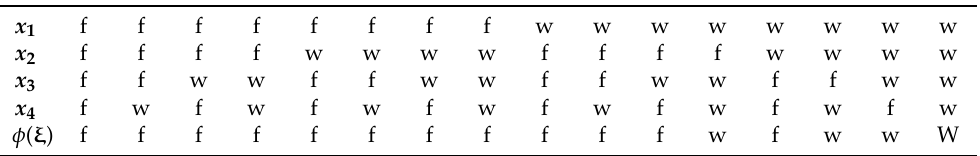
Table 1. Binary-State System (BSS) structure function of the system of a simplified laparoscopic surgery procedure [43].